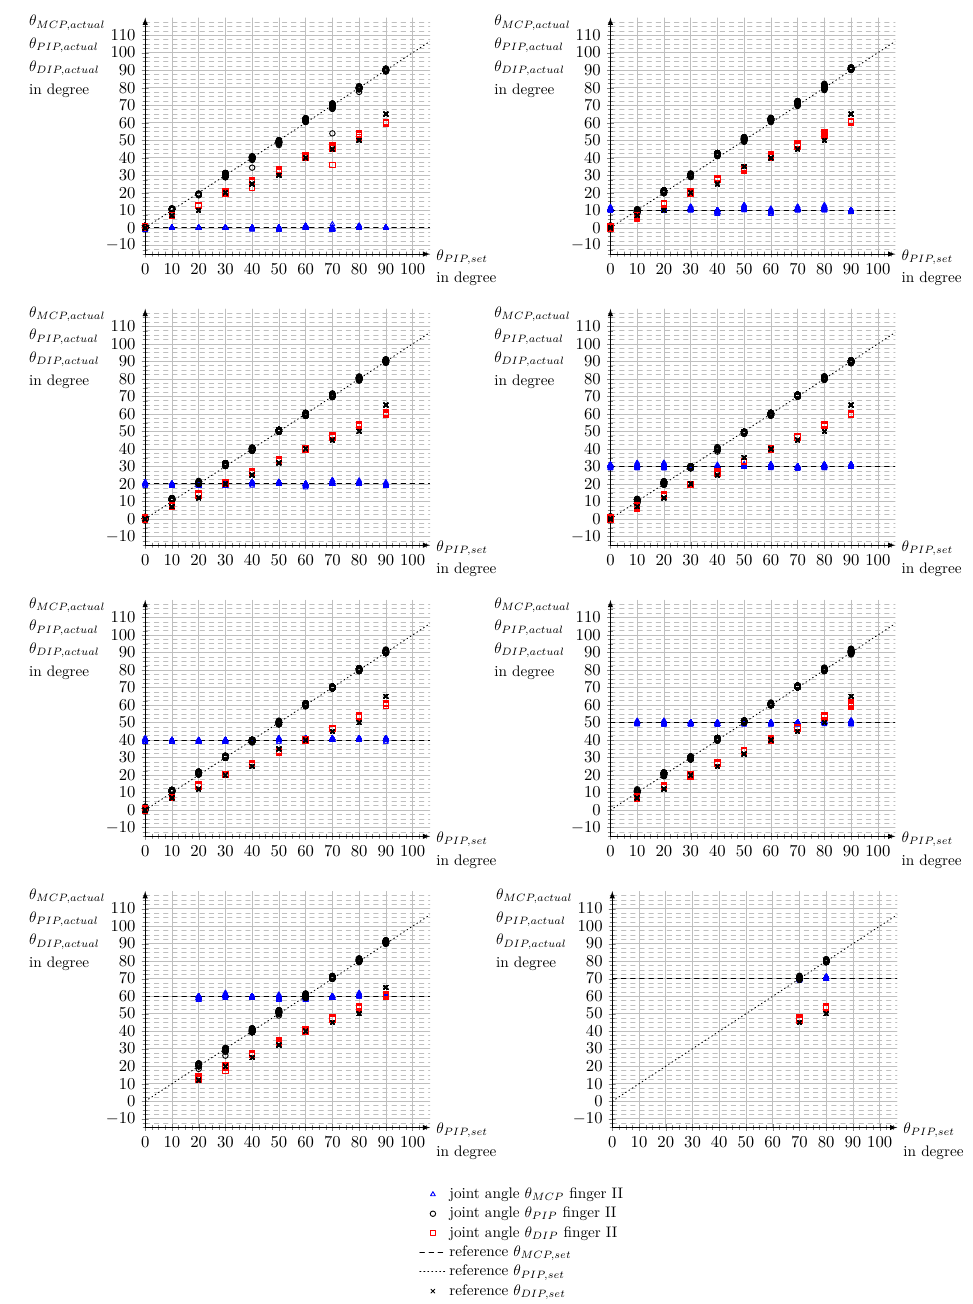
Figure A5. Accuracy of measurement for finger II. Joint angles θ set for the Metacarpophalangeal (MCP) joint from θ MCP , set = 0° to θ MCP , set = 70° and for the Proximal Interphalangeal (PIP) joint θ PIP , set . Reference for the Distal Interphalangeal (DIP) joint θ DIP , set calculated in dependence of θ PIP , set . Joint angles θ MCP , actual and θ PIP , actual measured with SenGlove. θ DIP , actual calculated in dependence of θ PIP , actual